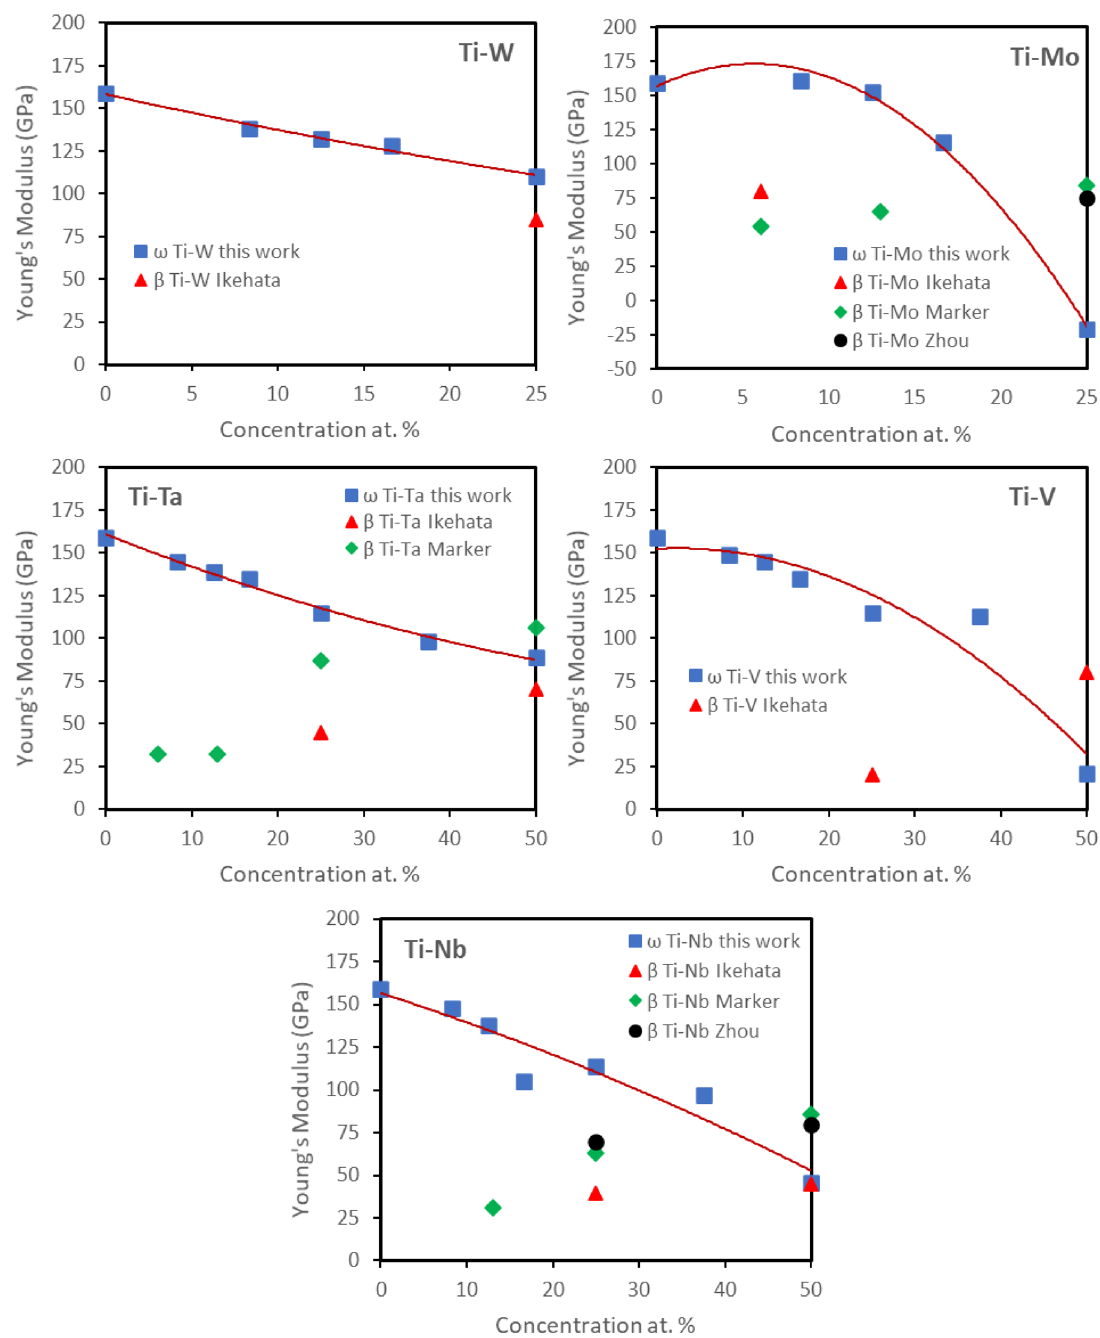
Figure 6. Calculated Young’s moduli of the ω-phase Ti-X binary systems (X = W, Mo, V, Ta, and Nb). Previous available calculated Young’s moduli values for β-phase are also included for comparison 8,18,19